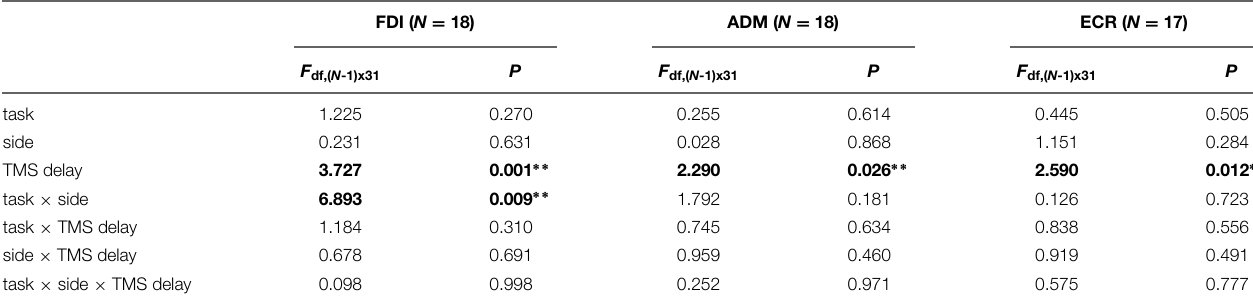
TABLE 1 | Three-way repeated measures ANOVA of stimulus-locked motor evoked potential (MEP) amplitudes.